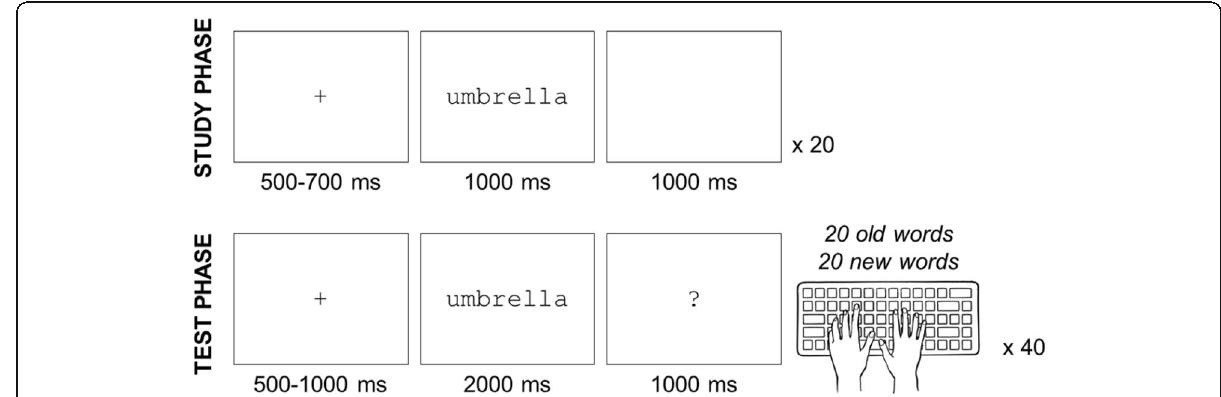
Fig. 1 Time course of one trial during the study phase and the test